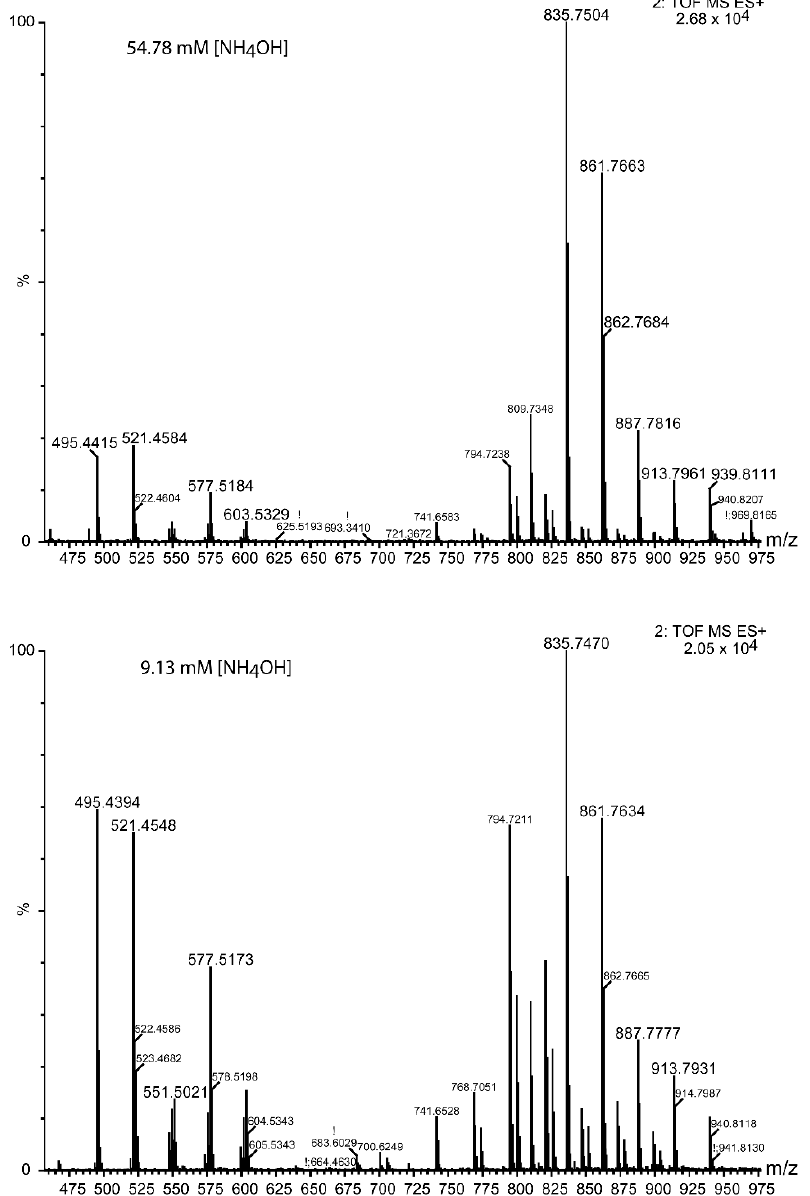
Figure 9. Example of a set of fragment peaks at a given time in the MS E . Table 2. Triacylglycerols (TAG) identified in an ovine plasma sample. More than one structure is proposed where no resolution was feasible. The regioisomery was established according to the rules found for the standard compounds. Rt means retention time.